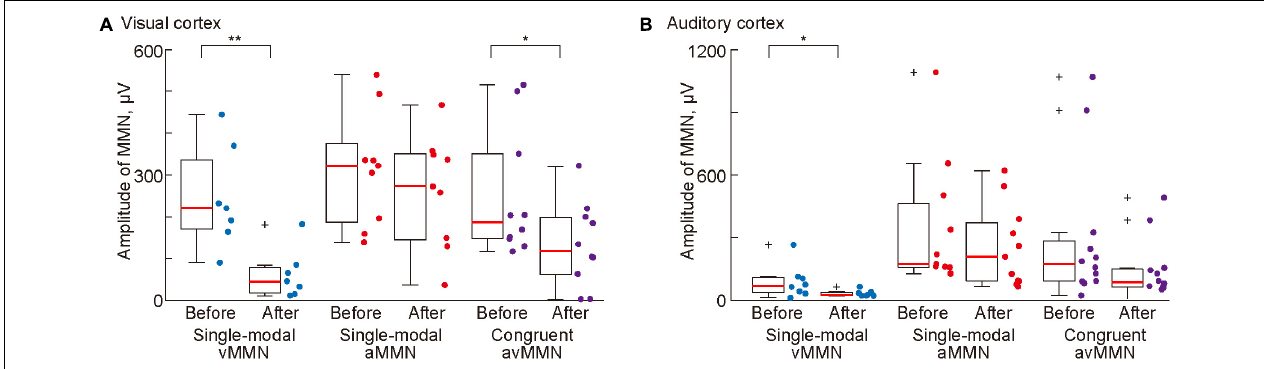
FIGURE 6 | Pharmacological effects of administration of an N -methyl- D -aspartic acid (NMDA) antagonist (AP5) in the visual cortex on mismatch negativity (MMN). Mean amplitude of MMN in (A) the visual and (B) auditory cortices before and after administration of AP5 to the visual cortex. Dots indicate the mean MMN amplitudes in each putative region in individual animals. Asterisks indicate statistical significance: * p < 0.05; ** p < 0.01 (Wilcoxon one-sided signed-rank